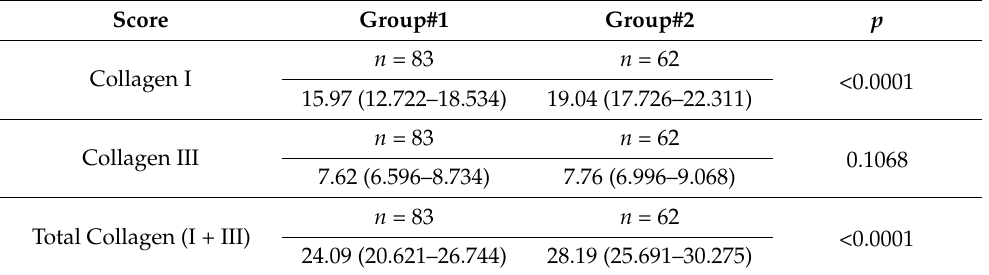
Table 3. Qualitative Analysis of Collagen Fibers I and III.